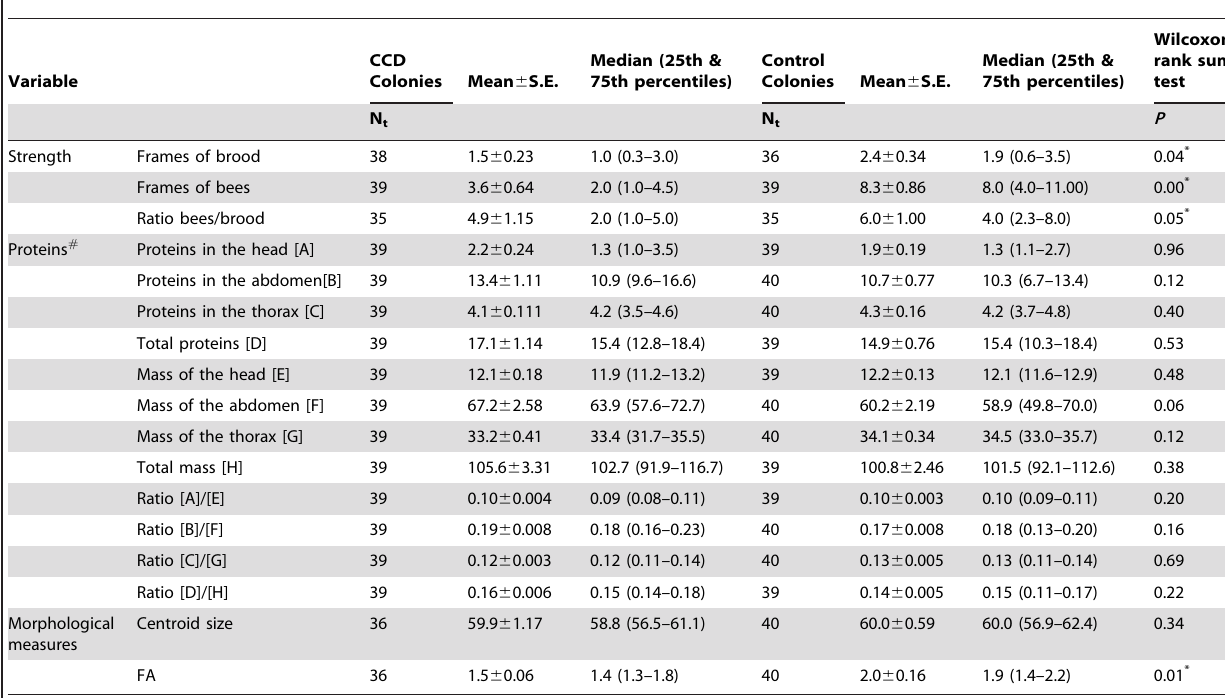
Table 3. Strength and mean physiological and morphometric measurements of bees from colonies considered to be normal (control) or affected by CCD (N t ).